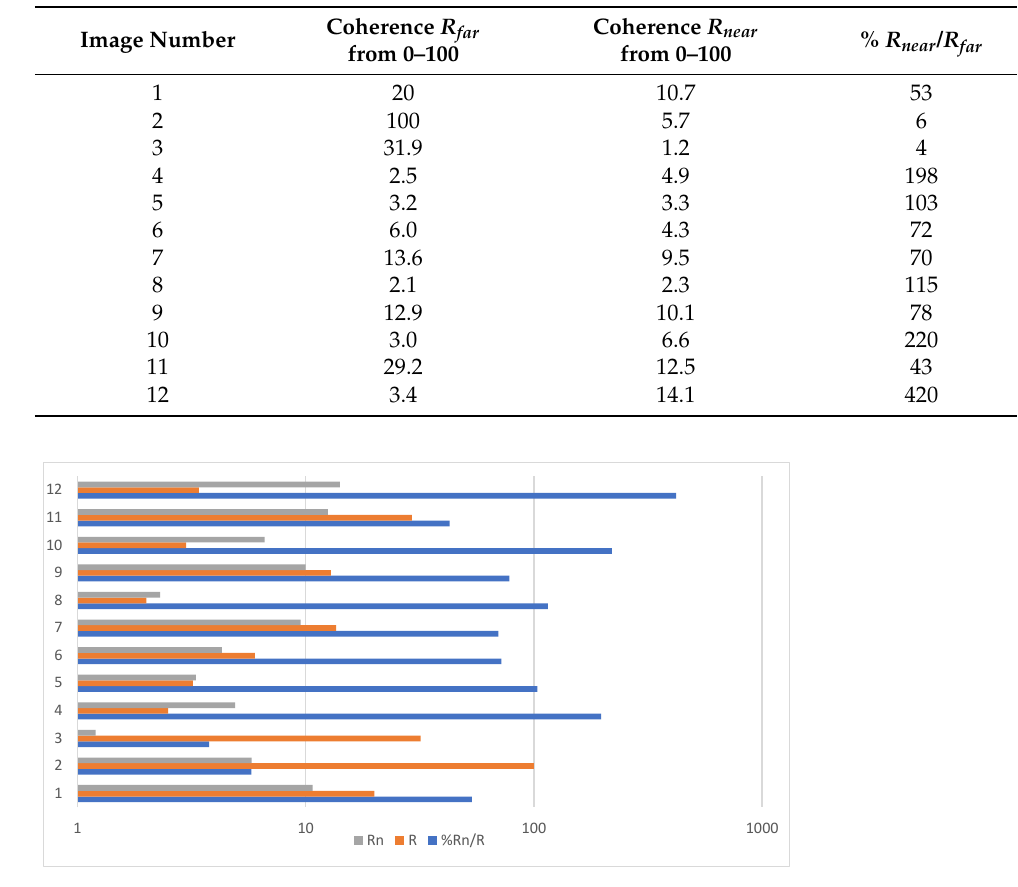
Table 1. Values of “ R ” measuring the visual coherence of the 12 buildings illustrated in Figure 1.